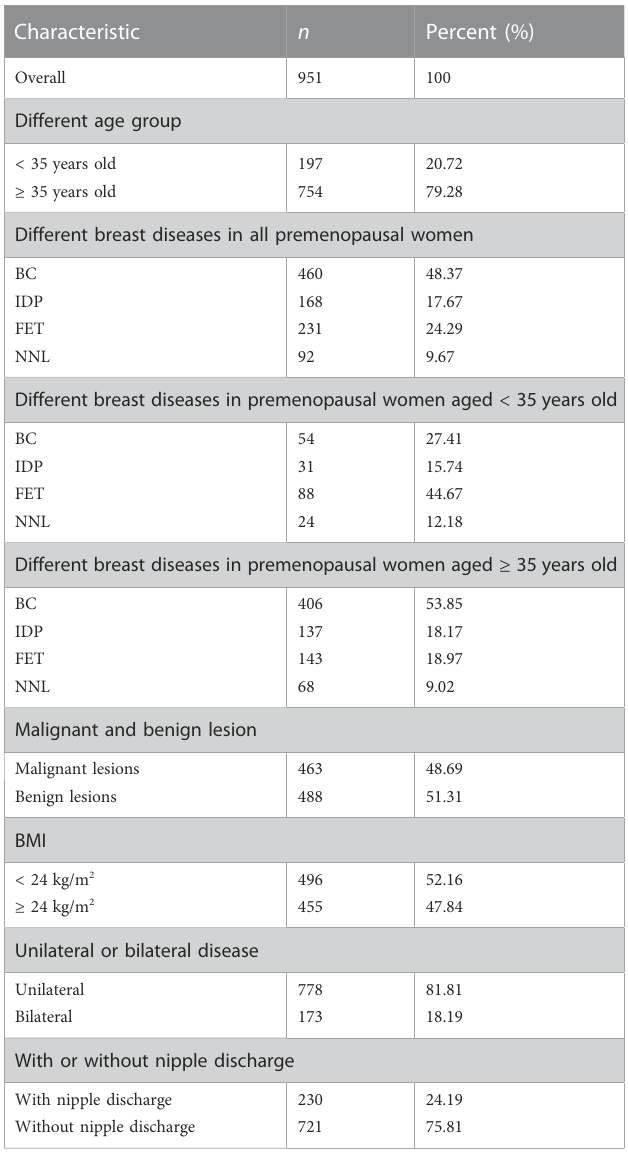
TABLE 2 Characteristics of post-menopausal women with breast